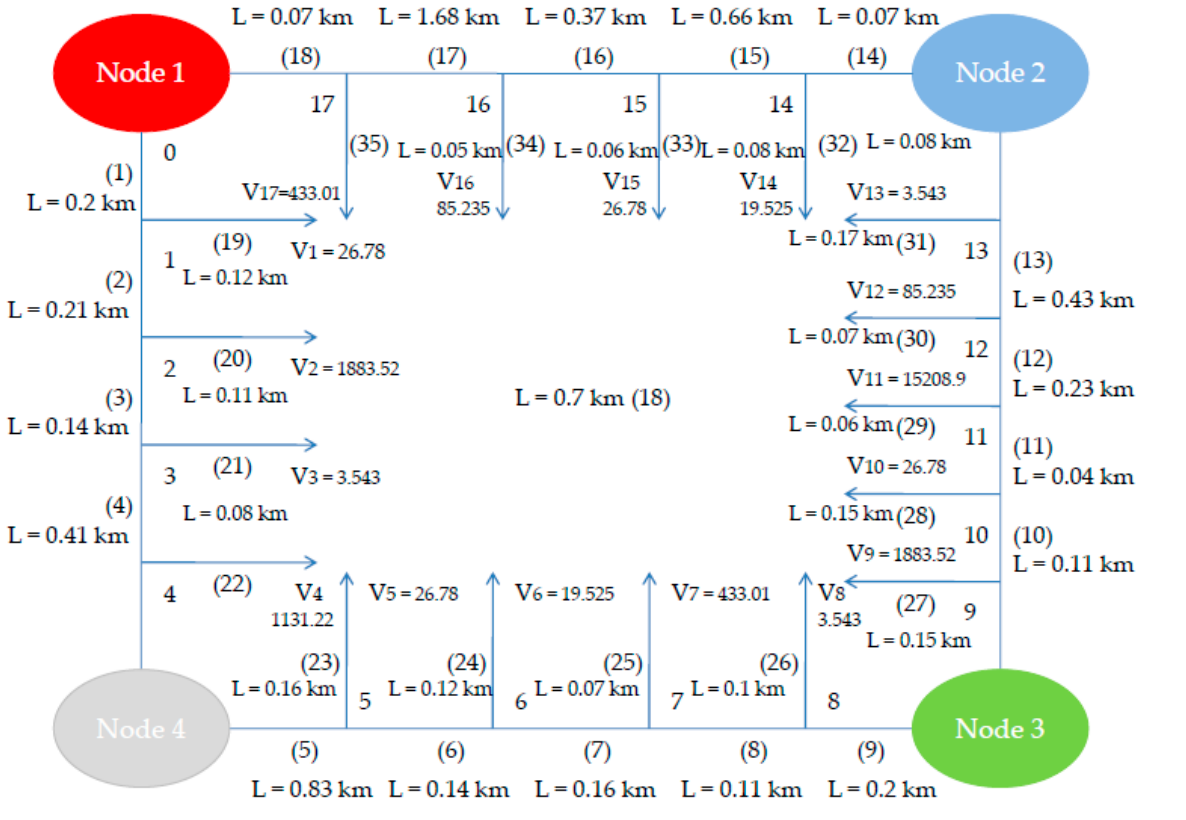
Figure 2. The calculation diagram of a high-pressure ring gas pipeline. Gas pipeline routes are designed based on the minimum length of the network. At the same time, high-pressure gas pipelines are being laid along the outskirts of the city, where there is a low population density and a smaller number of underground